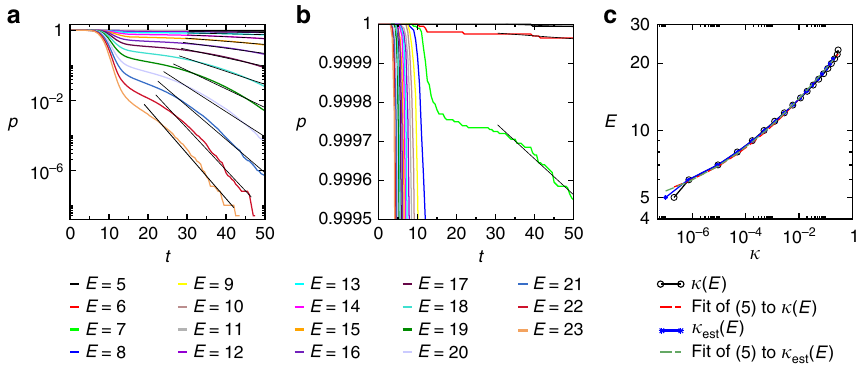
Fig. 2 Energy dependent escape rate. a The p ( E , t ) distributions for a hard, benchmark MaxSAT competition problem with N = 250, M = 1000 ( α = 4.0), “ HG-3SAT-V250-C1000-1.cnf ” , from ref. 49 . We fi nd E = 5 with our algorithm after running Γ = 2 × 10 5 trajectories with b = 0.002375. The escape min rates are obtained from fi tting p ~ e − κ t onto the last section of the distributions (black lines), see Methods. b A zoom into the upper section of ( a ). c E vs. the escape rate κ using the values obtained from the fi tting shown in ( a ) (black) and using the rough estimate for the escape rates κ est ( E ) ≃ − ln( p ( E , t max ))/ t fi tting procedure (see Methods). The dashed lines show the max (blue). This estimation is convenient, as it is easier to automate in the algorithm than the fi tting of Eq. (5) to the κ ( E ) points from ( a ) (red curve: E = 4.25 + 22.87 κ 0.184 ) and to the κ E ) points (green curve: E = 4.06 + 22.31 κ 0.178 ), respectively. est ( Both curves result in E 0 ∈ (4, 5] thus predicting the global optimum E pred min (cid:6) (cid:7) in total to fi nd the lower energy value E (cid:2) 1, i.e., Γ pred E (cid:2) 1